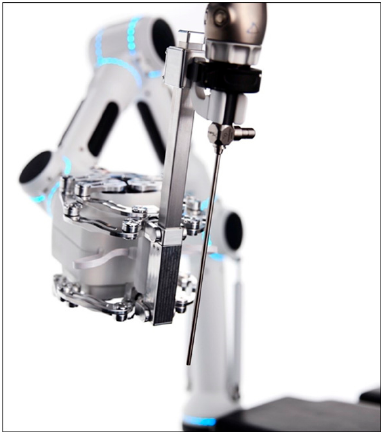
Figure 6. Cirq ® . Robot-assisted endoscope guidance system with a mechatronic arm consisting of several segments with 7 degrees of freedom and the possibility to attach a conventional endo- scope. Reproduced with kind permission from Medineering/Brainlab ® , Munich, Germany, © 2021.